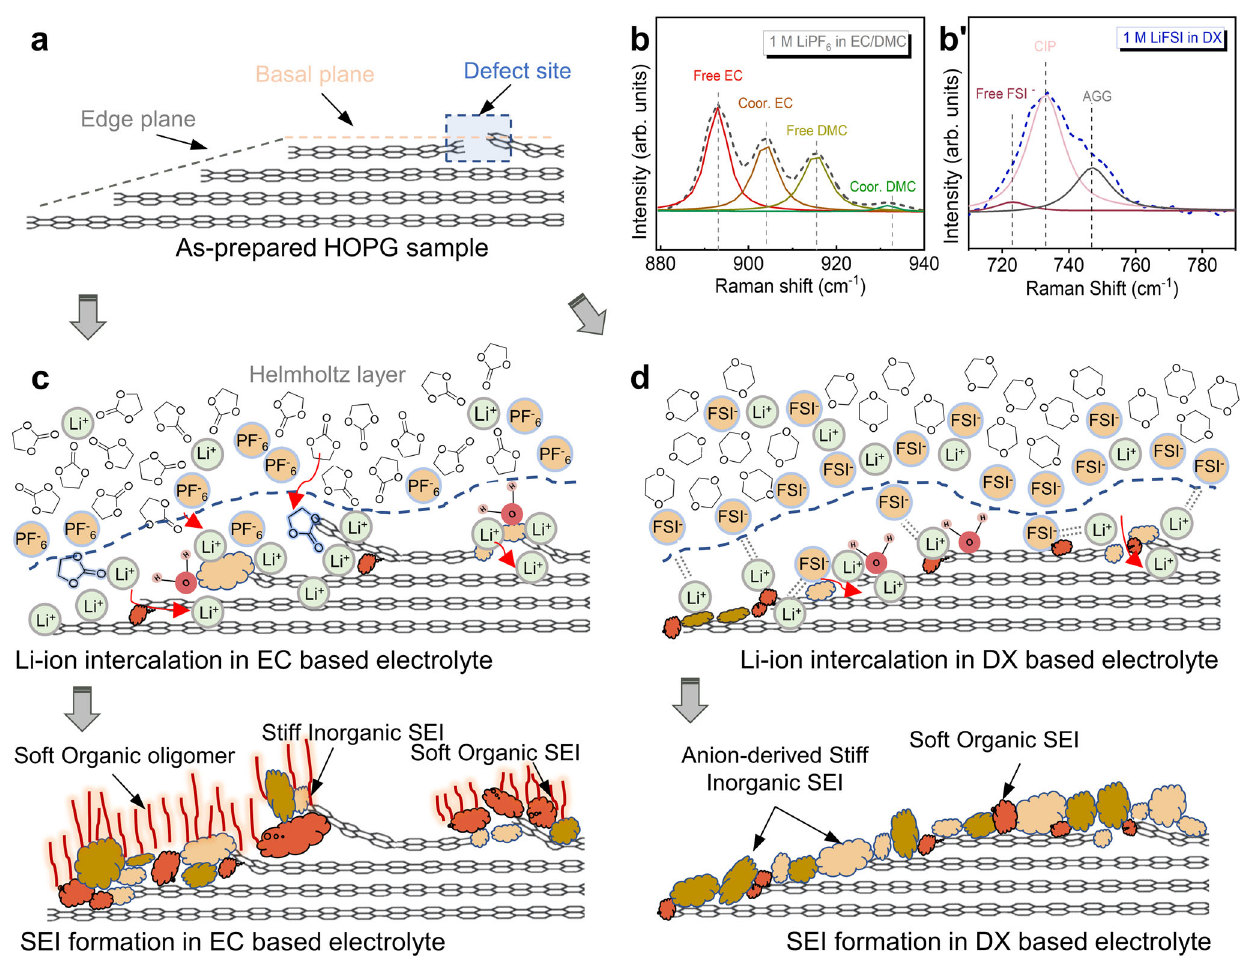
Fig.5|Schematicdiagramrepresentingthenanoscaleandatomisticpictureof initial SEI formation mechanisms. a As-prepared HOPG model sample with calibratedgraphiteedgeplaneandbasalplane(scatterednaturaldefectsmayexist on the graphite basal planes). Raman spectroscopy characterization of two elec- trolyte solvationstructures in bulk, b C – O stretching vibrationalband of EC-based